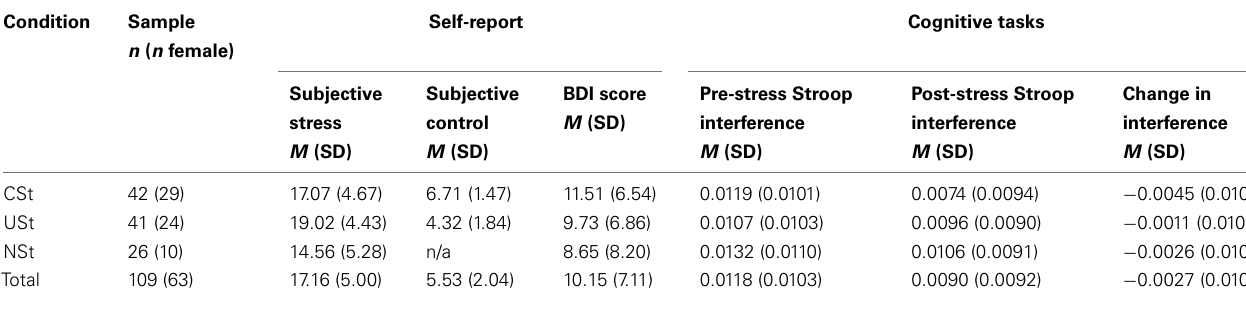
Table 1 | Demographics and descriptive statistics for Experiment